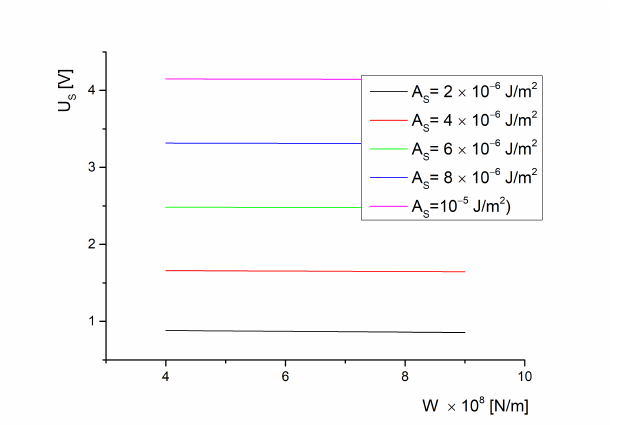
Figure 3. Saturation voltage versus interaction energy density between molecules and